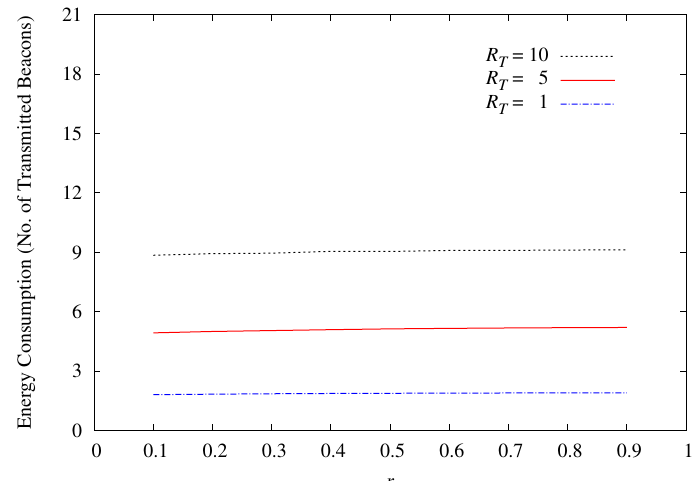
Figure 10. Impact of R T on energy consumption.